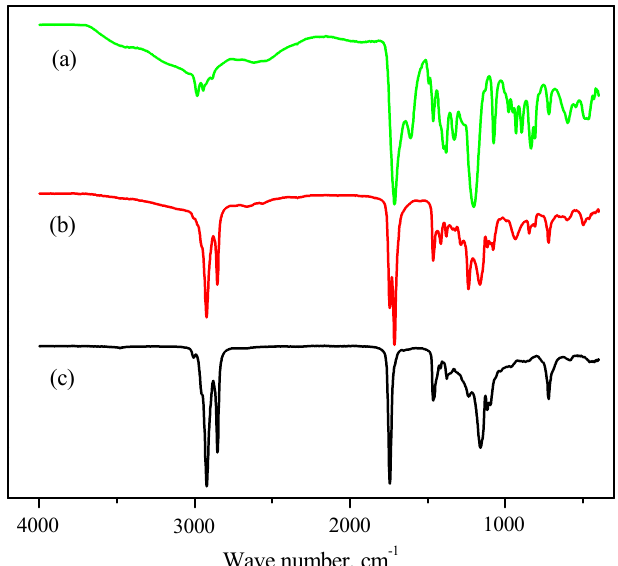
Figure 4. Infrared spectra of DES-rich phase ( a ), oil-rich phase ( b ), and palm oil before extraction ( c ); DES: betaine monohydrate-propionic acid with a mole fraction of acid of 0.89.